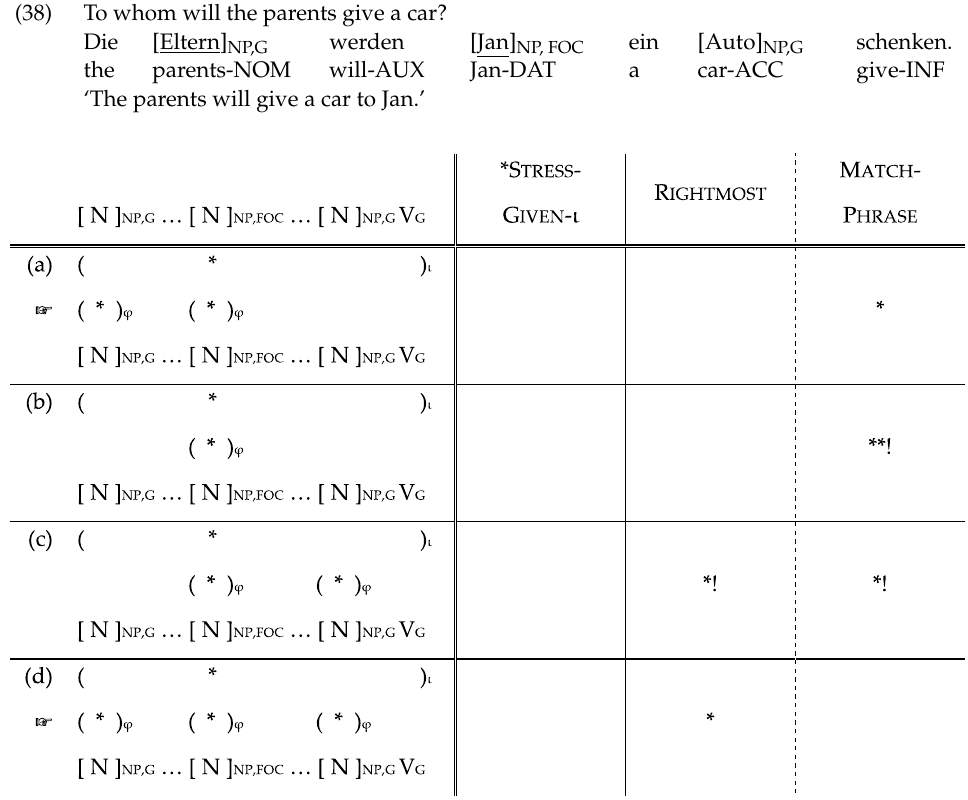
Figure 5. Prosodic structures predicted by *S TRESS -G IVEN - ι >> R IGHTMOST , M ATCH -P HRASE for a sentence with a focused NP preceded and followed by unfocused given NPs.